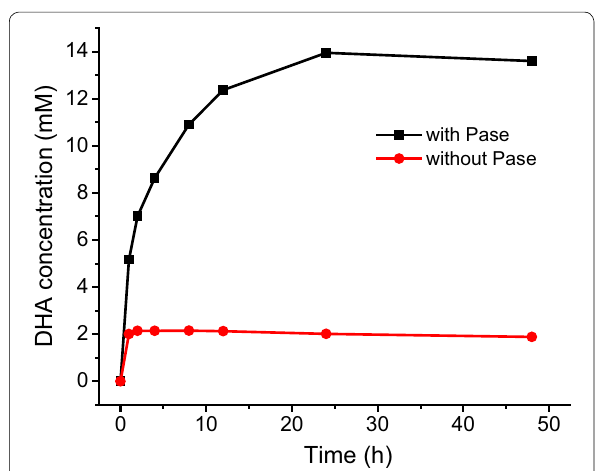
Fig. 7 Production of DHA from maltodextrin. The reaction was performed in 100 mM HEPES buffer (pH 7.0) containing 10 g/L isoamylase treated maltodextrin, 5 mM MgCl 2 , 10 mM Pi, 0.18 g/L (1 U/mL) EcoαGP, 0.05 g/L (1 U/mL) CtPGM, 2.52 mg/L (1 U/mL) CtPGI, 0.17 g/L (1 U/mL) EcoFSA, 6.7 mg/L (1 U/mL) TtcTIM, and in the absence (close circle) and presence (close square) of 10 g/L (1.6